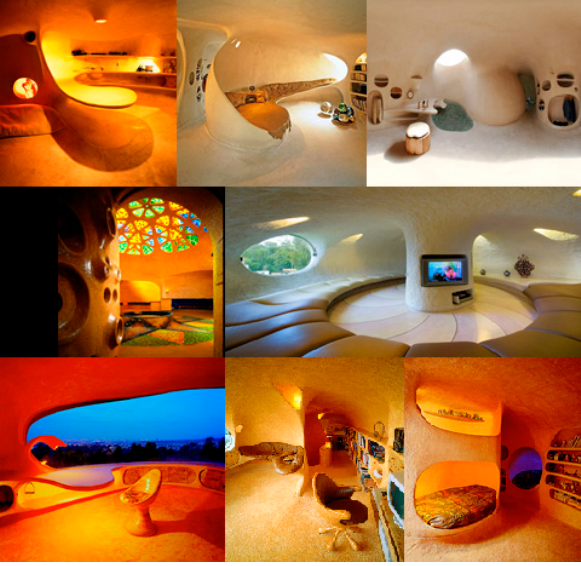
Figure 25. Main views of the interior lighting system.